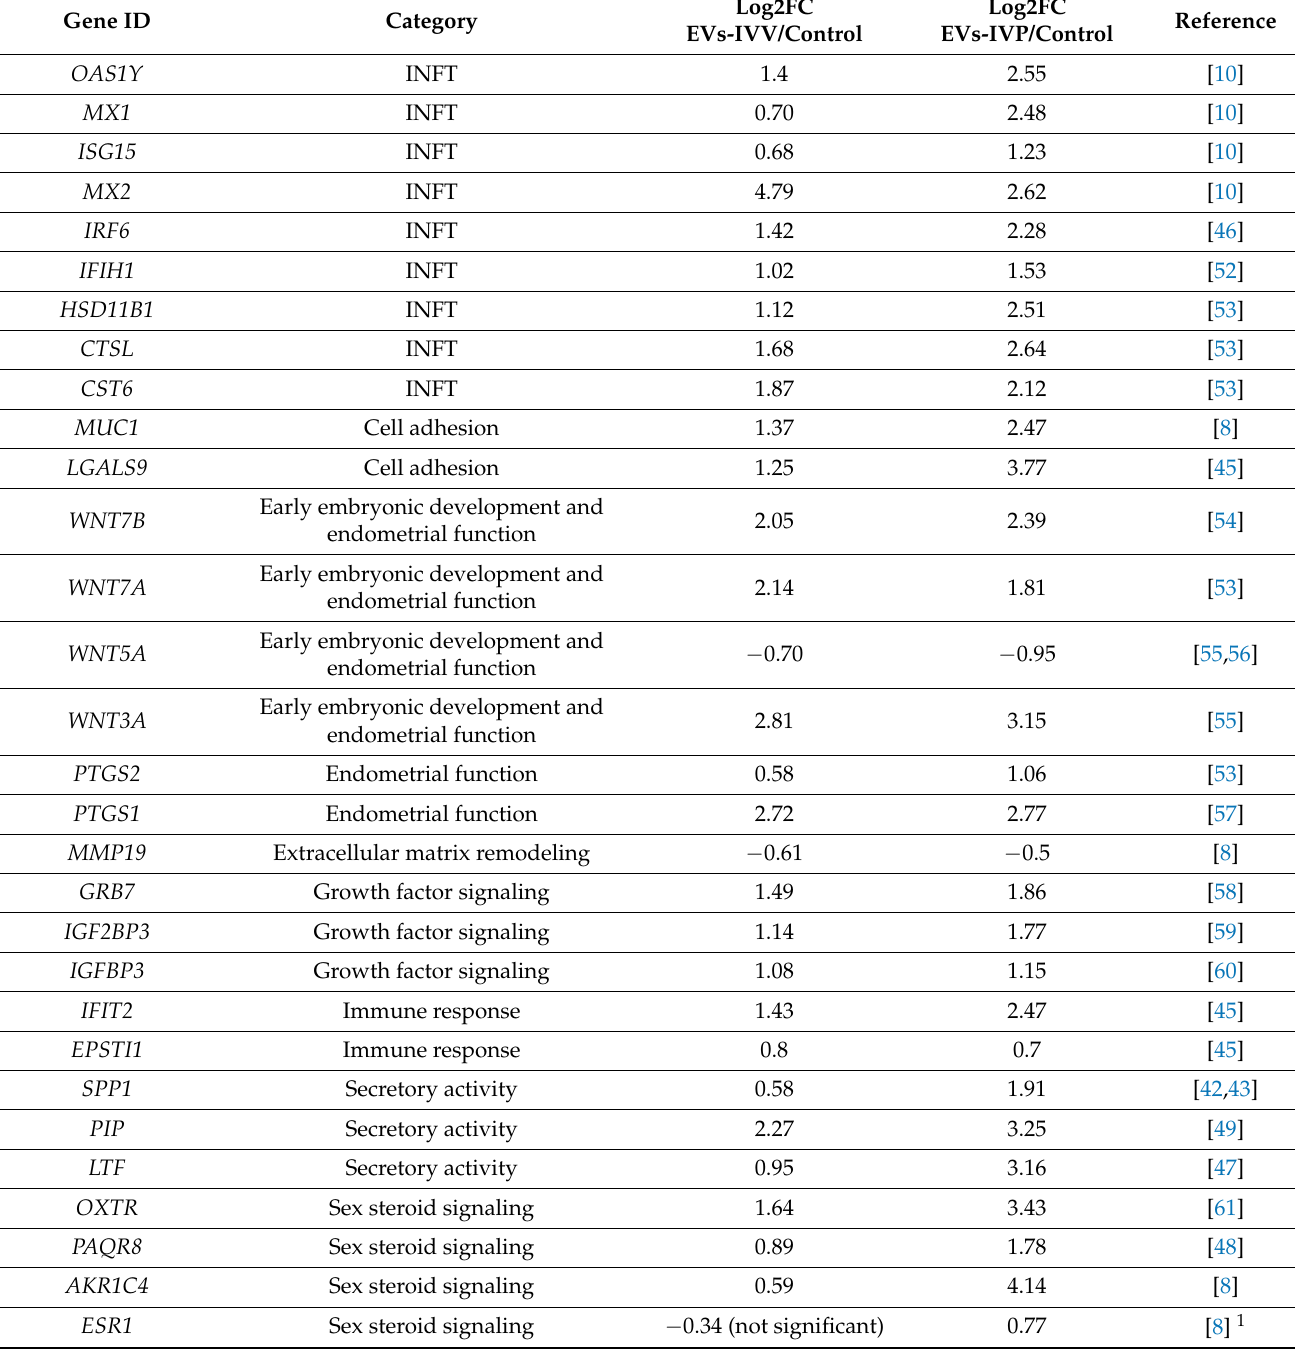
Table 4. Genes associated with IFNT signaling or endometrial function that are significantly dereg- ulated in epithelial endometrial cells due to the effect of extracellular vesicles secreted by